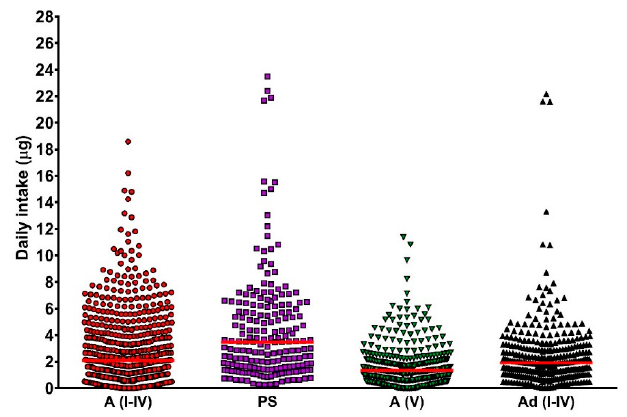
Figure 2. Daily oral vitamin D intake for all volunteers (all seasons). There were no significant differences in intake between seasons [15–17,19]. Red bars are the median for each group. A: adult; Ad: adolescent; PS: photosensitive; I–IV and V refer to volunteer skin types.